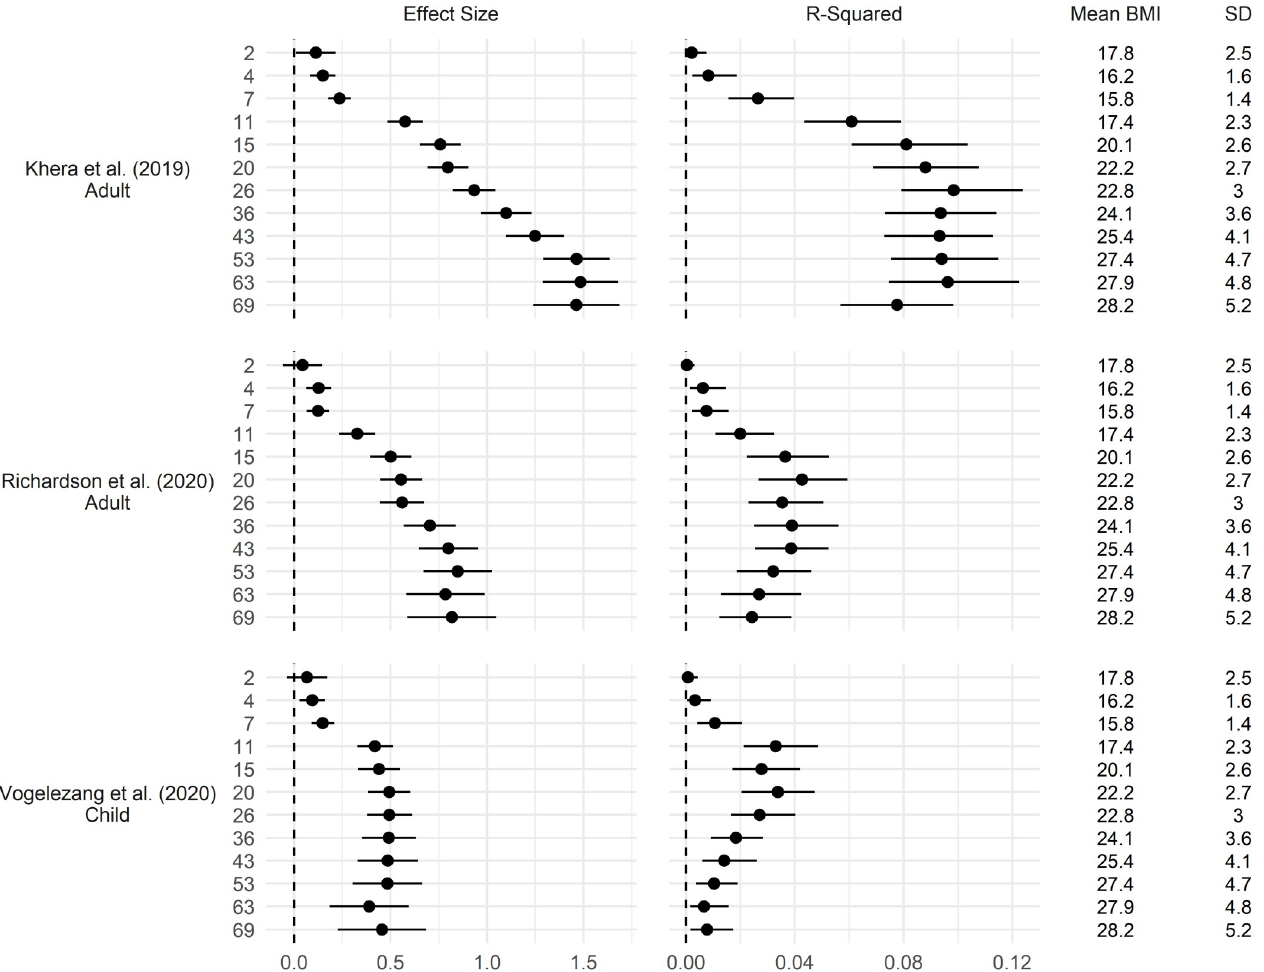
Fig 5. Association between multiple polygenic indices and body mass index (BMI) across life. Drawn from OLS regressions including adjustment for sex and first 10 genetic principal components, repeated for each polygenic index and age at follow up. Left panel: coefficient difference in BMI per 1 SD increase in polygenic index (+ 95% CI). Right panel: incremental R 2 compared to OLS regression model of BMI on sex and first 10 genetic principal components (95% CI estimated using bootstrapping [500 replications, percentile method]). Khera et al [4]: 2,100,302 SNPs (genome-wide SNPs); Richardson et al [7]: 557 SNPs (significant hits only); Vogelezang et al. [8]: 25 SNPs (significant hits only).